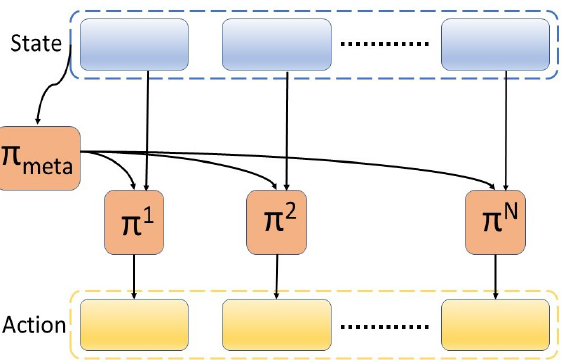
Figure 3. Multi-agent reinforcement learning framework with a